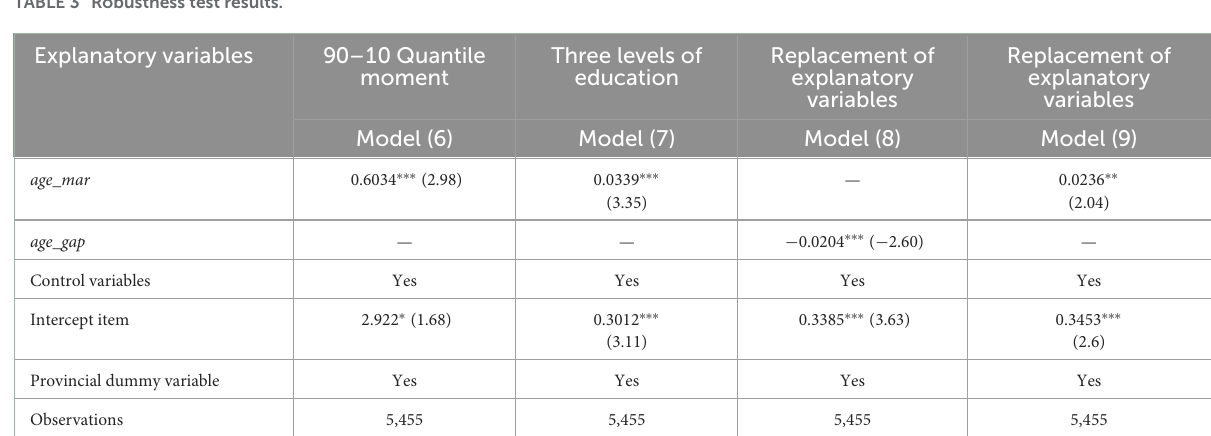
TABLE 3 Robustness test